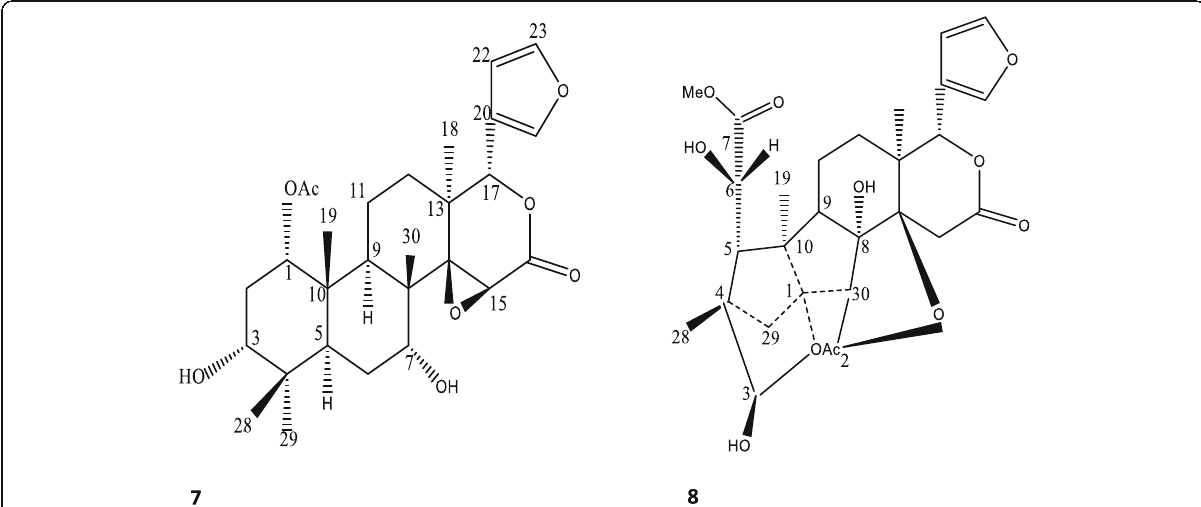
Fig. 9 Structure of limonoids from the stem bark of K. senegalensis . (7) 3 α , 7 α -dideacetylkhivorin. (8) 1-O-acetyl Khaya nolide. Adapted from [14]. All structures were drawn with